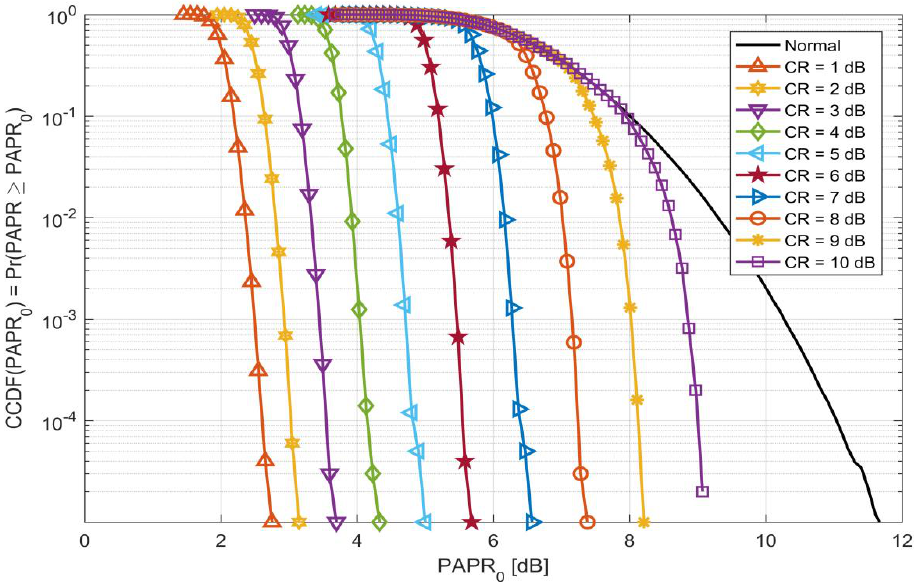
Figure 12. Complementary Cumulative Distribution Function (CCDF) of PC-OFDM with 4-QAM for different Clipping Ratios.